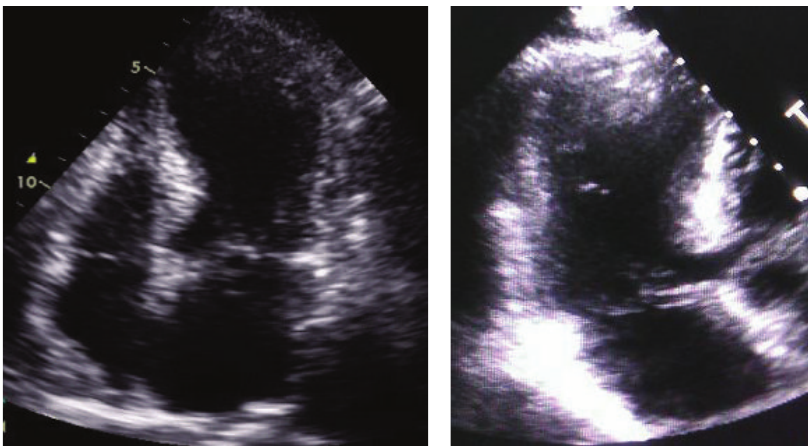
Figure 2: Echocardiography showing apical hypokinesis with preserved basal function.